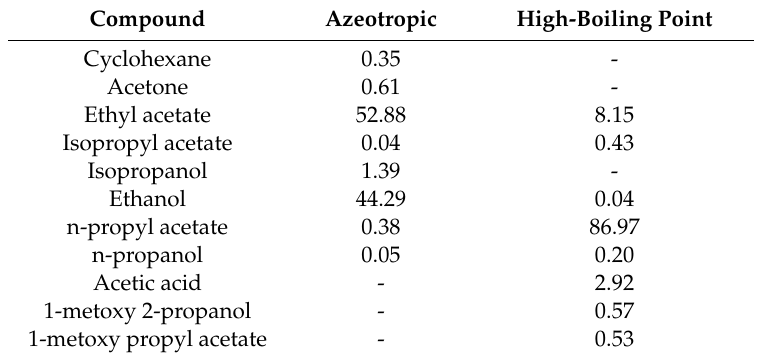
Table 2. Compositions (wt %) of azeotropic (AZ) and high-boiling point (HB) solvents mixtures. Compound Azeotropic High-Boiling